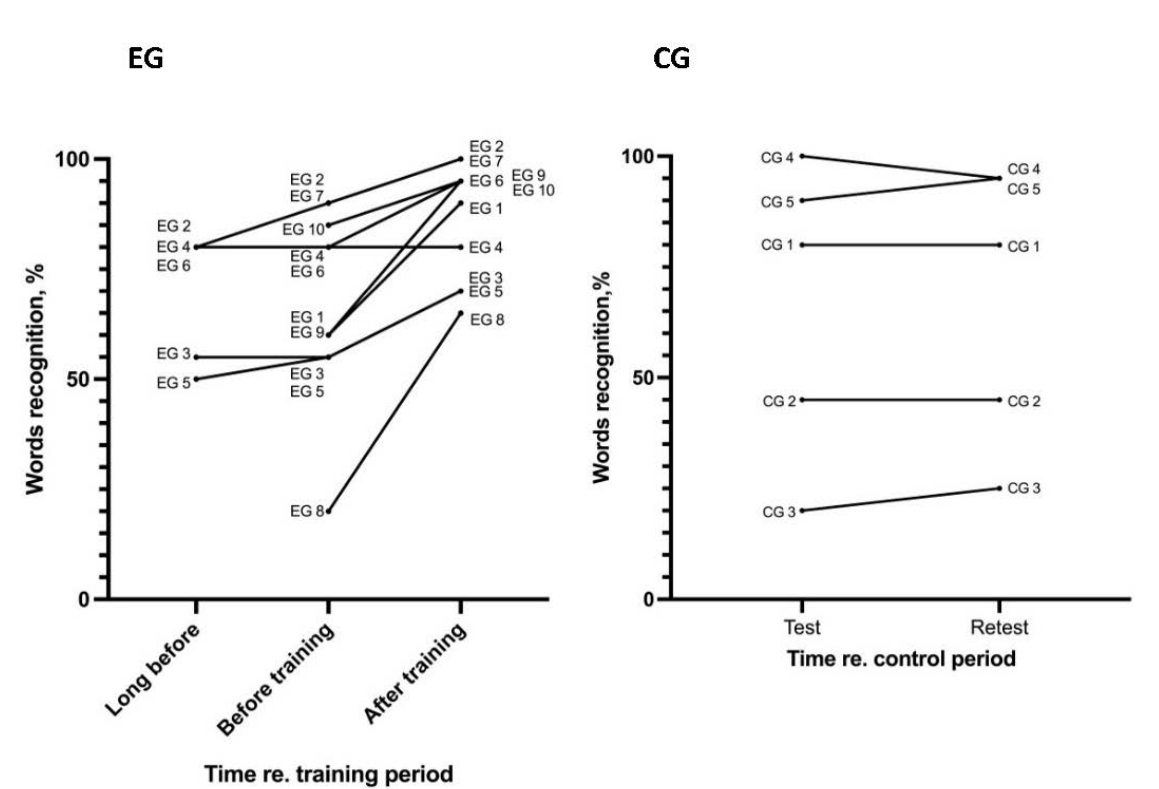
Figure 3. The percentage of recognized words for EG (long before, immediately before training, and after training) and for CG (test/retest). Each line indicates results for one CI user. We had “long before” (more than 8 months before training) data of word recognition for 5 out of 10 EG CI users. For two of these five CI users (EG 3 and 6), the